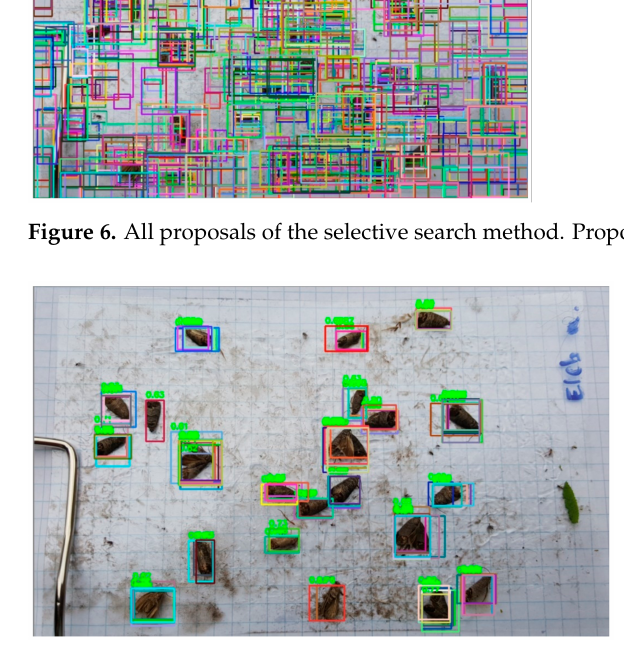
Figure 7. Proposals where the IoU ≥ 0.8. Proposals are visualized in random colors.